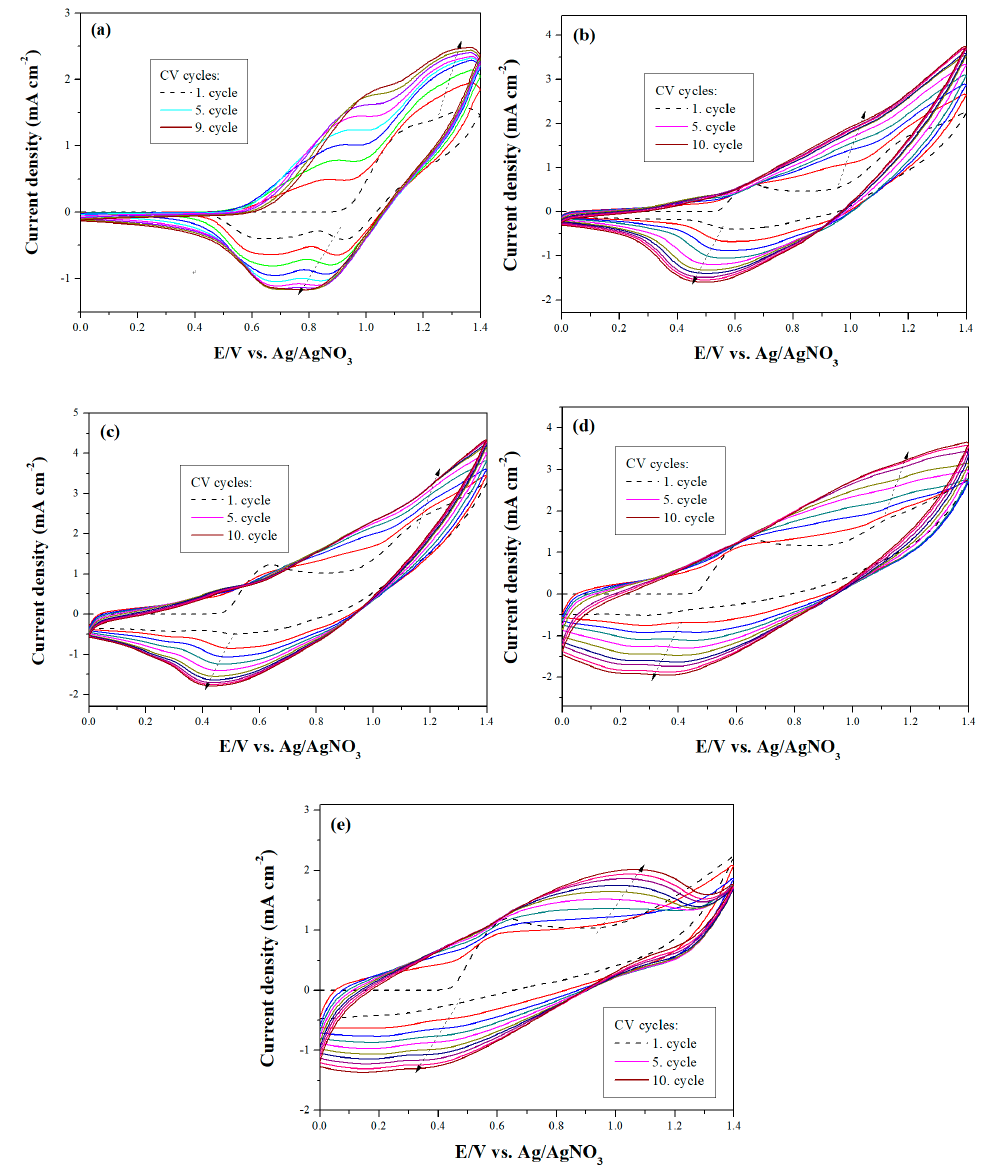
Figure 1. Electrochemical synthesis of ( a ) PdCz; ( b ) P(dCz2- co -dTC1); ( c ) P(dCz2- co -dTC2); ( d ) P(dCz1- co -dTC2) and ( e ) PdTC in ACN/DCM (1:1, by volume) solution at 100 mV s − 1 on ITO working electrodes.